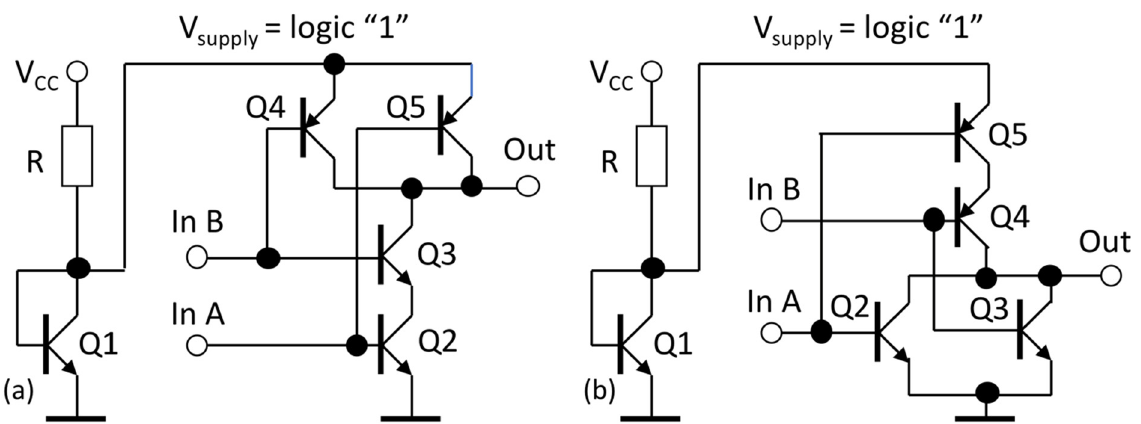
Figure 12. Thermally stabilized CBip gates. ( a ) NAND gate, ( b ) NOR gate.